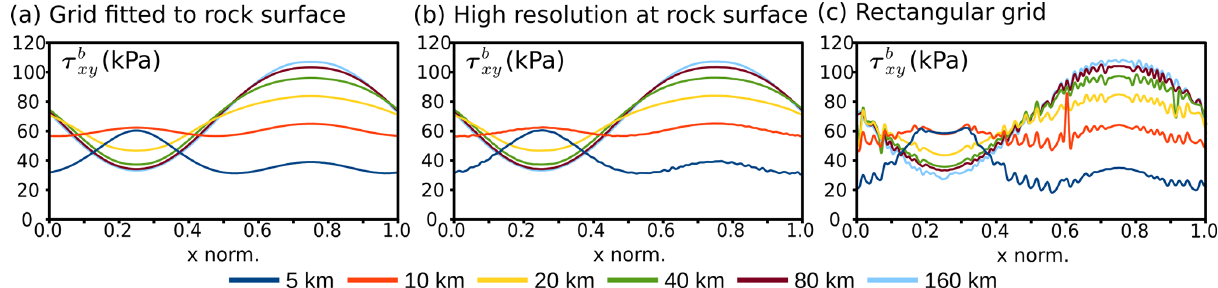
Figure 7. The basal shear stress τ b xy (in kPa), calculated on (a) a grid fitted to the rock surface, and (b) a structurally more conforming grid, which increases mesh resolution at the rock surface and (c) a rectangular grid. The experiments are based on a grid resolution of 128 × 64.